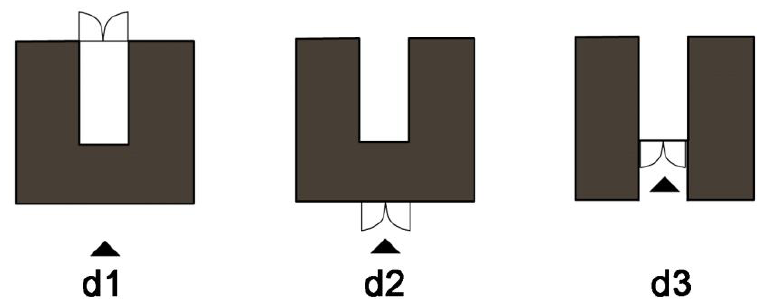
Figure 7. Plan form facing the road (A + B + C) Reprinted/adapted with permission from Ref. [3]. 2018, Donghwa Shon: The facade appears in various ways according to the combination of the type and layout of the main house and gate building, and the orientation of the road. These images are exemplary images that various facades can appear depending on the combination of elements for each class A, B, and C.